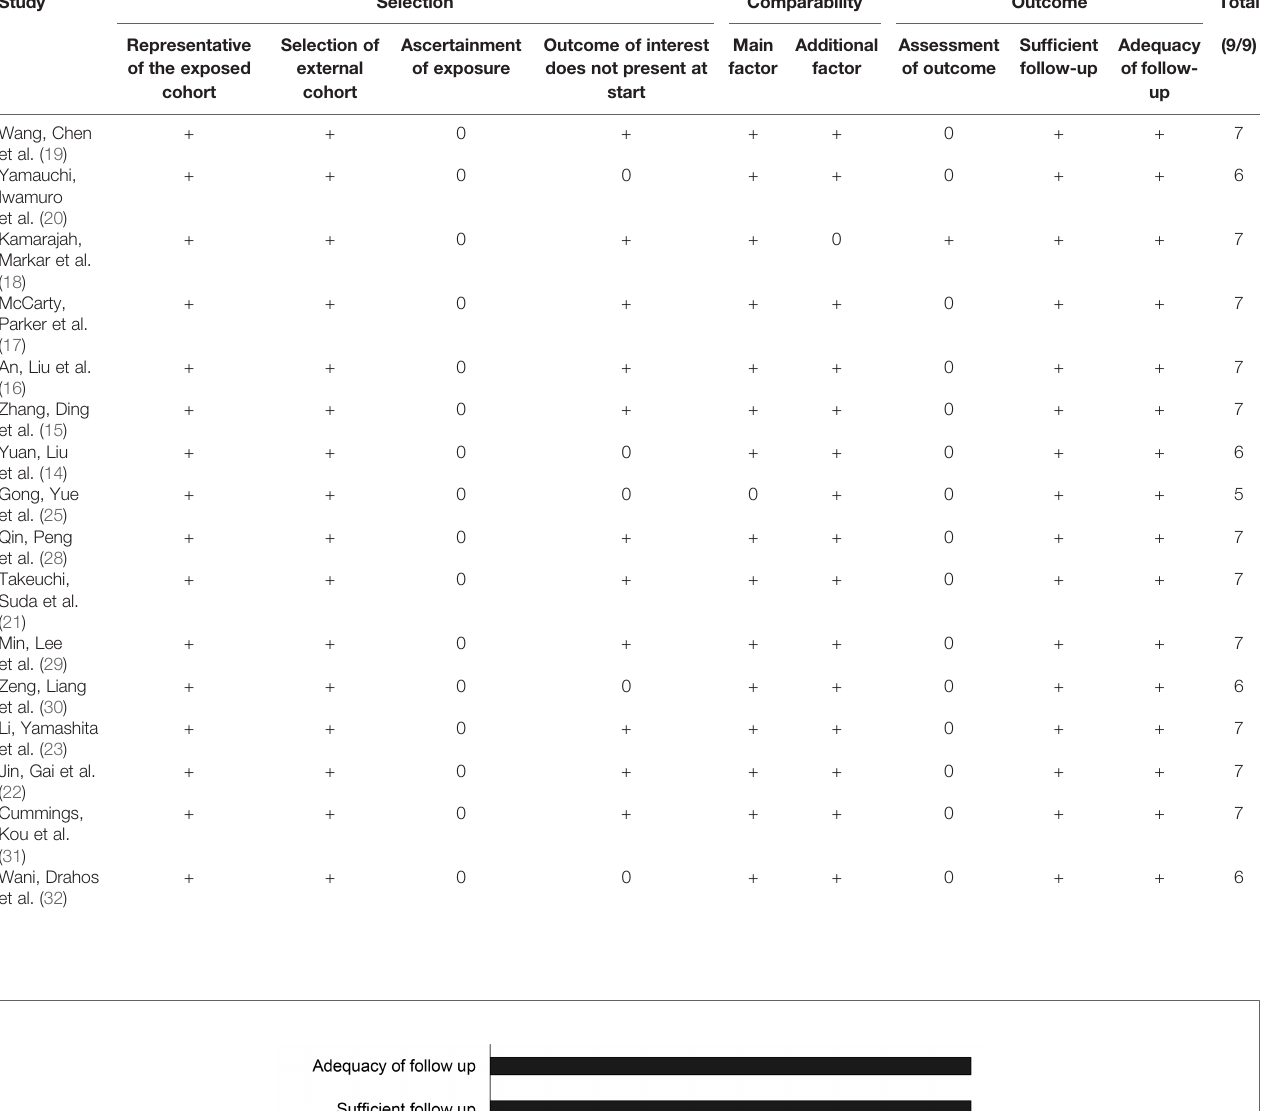
TABLE 2 | Risk of bias for individual studies based on the Newcastle – Ottawa scale (+: low risk of bias, 0: high risk of bias).